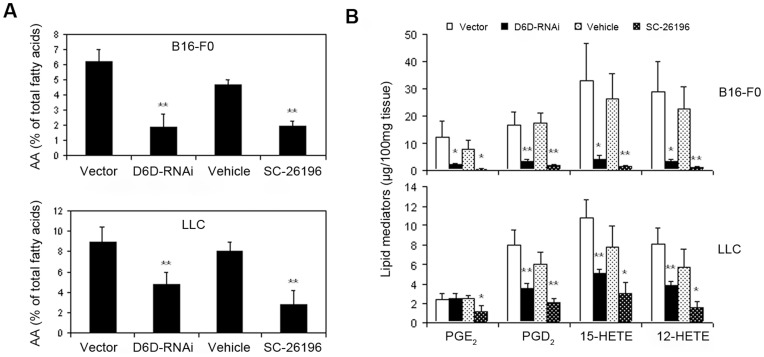
Decreased D6D reduces the levels of AA and AA-derived eicosanoids in tumor tissue.Knocking down D6D (with RNAi) or inhibiting D6D (with selective inhibitor SC-26196) decreased (a) AA and (b) AA metabolite levels in mouse models of B16 melanoma and LLC. *P<0.05; **P<0.01; n = 3–5.